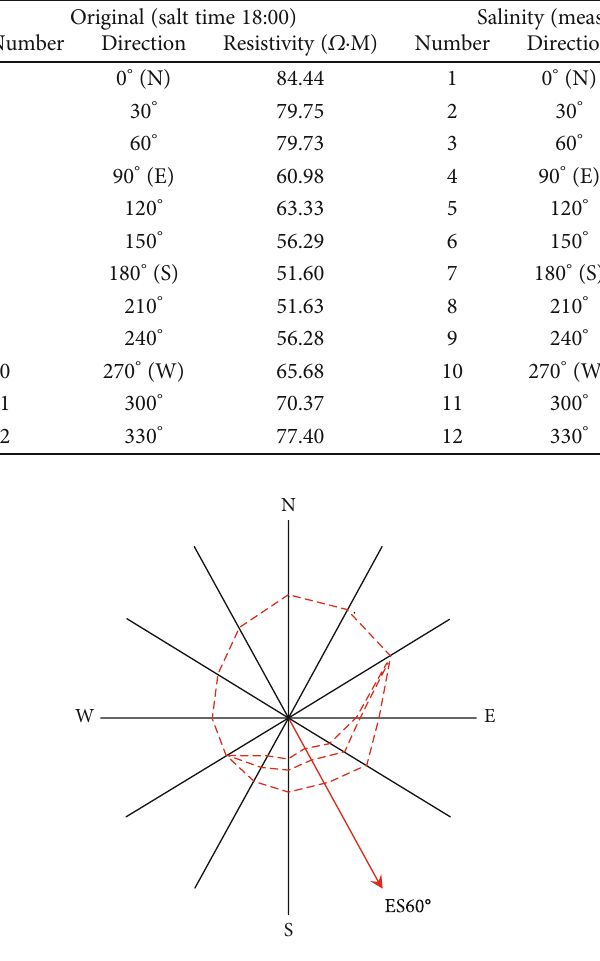
Figure 5: Water fl ow direction result